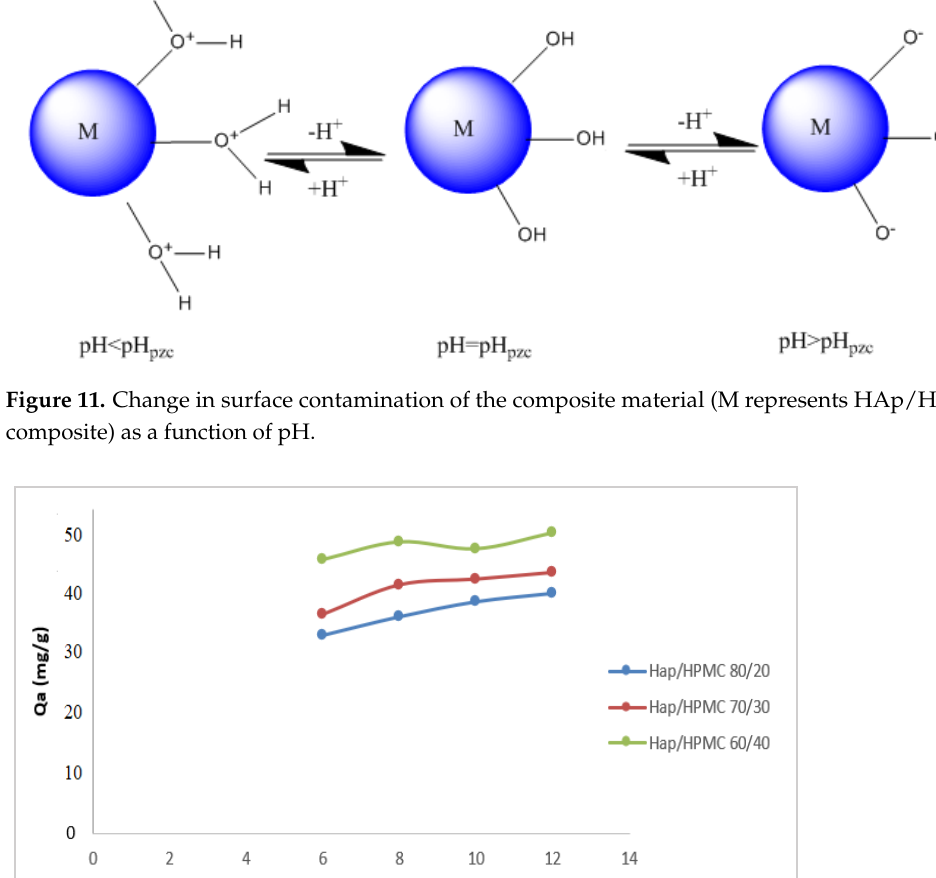
Figure 11. Change in surface contamination of the composite material (M represents HAp/HPMC composite) as a function of pH.